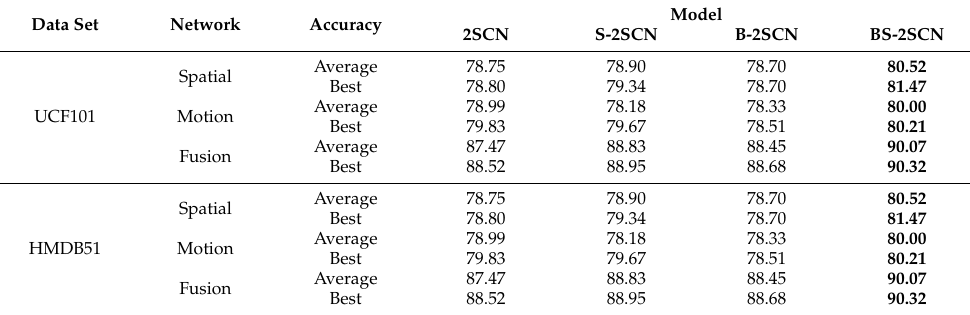
Table 2. Comparison of action recognition accuracy (%).